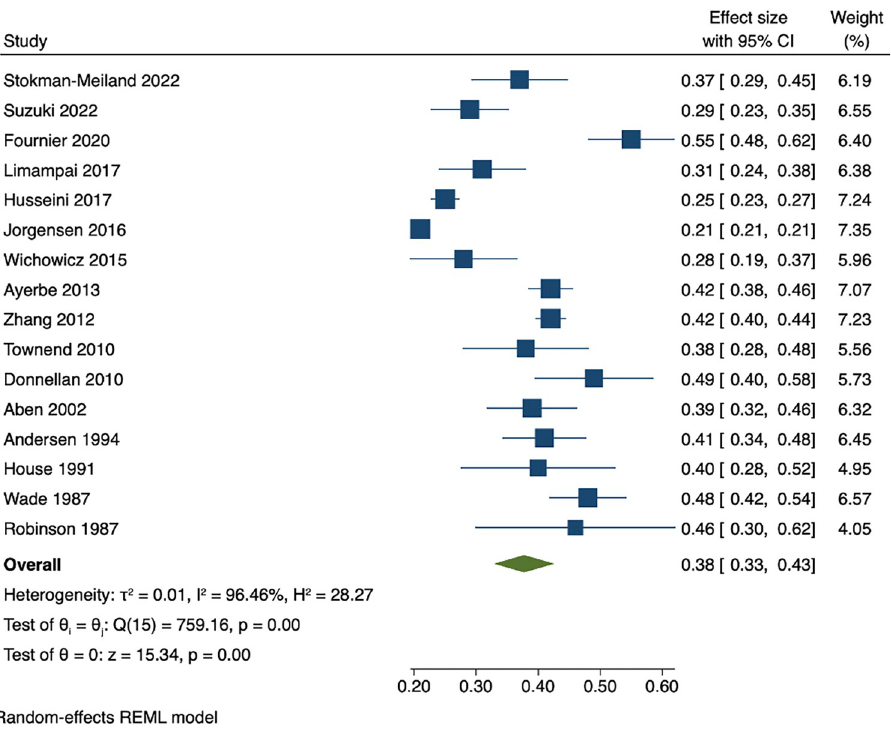
Fig 6. Cumulative incidence of depression within 1 year after